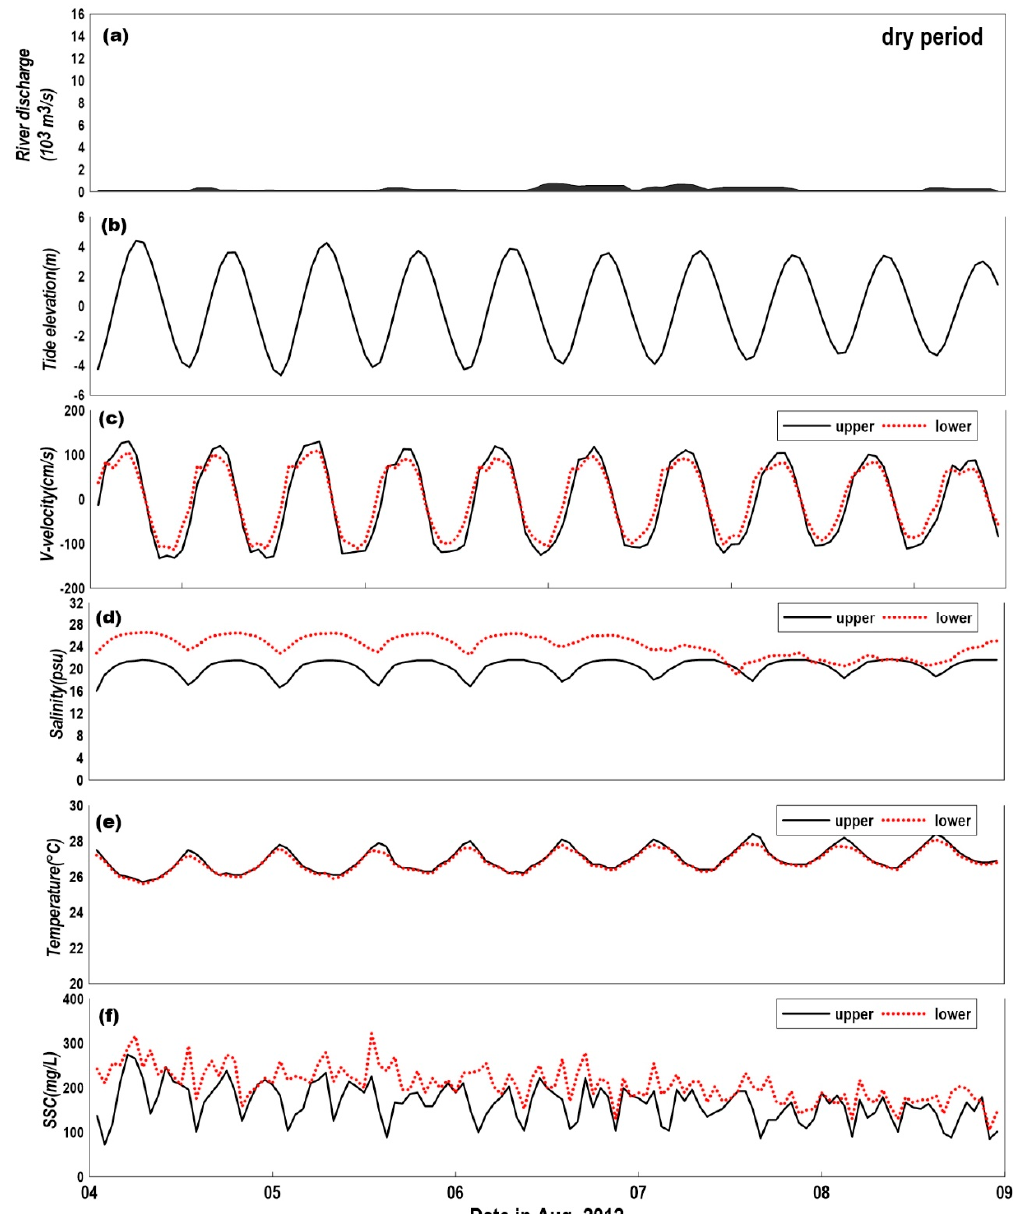
Figure 3. Time series of the observed data during the dry period: ( a ) freshwater discharge from Han River, ( b ) tide elevation of Incheon station, ( c ) horizontal flow velocity (+: north, − : south), ( d ) salinity, ( e ) temperature, and ( f ) SSC.